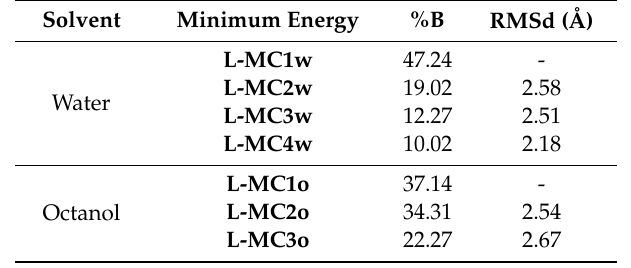
Table 1. %B and Root Mean Square deviation (RMSd) values of the most probable energy minima for loperamide, obtained after MC simulations conducted both solvents. RMSd values (Å) are calculated on the heavy atoms of loperamide compared to the global energy minima ( L-MC1w and L-MC1o ). Solvent Minimum Energy %B RMSd (Å)